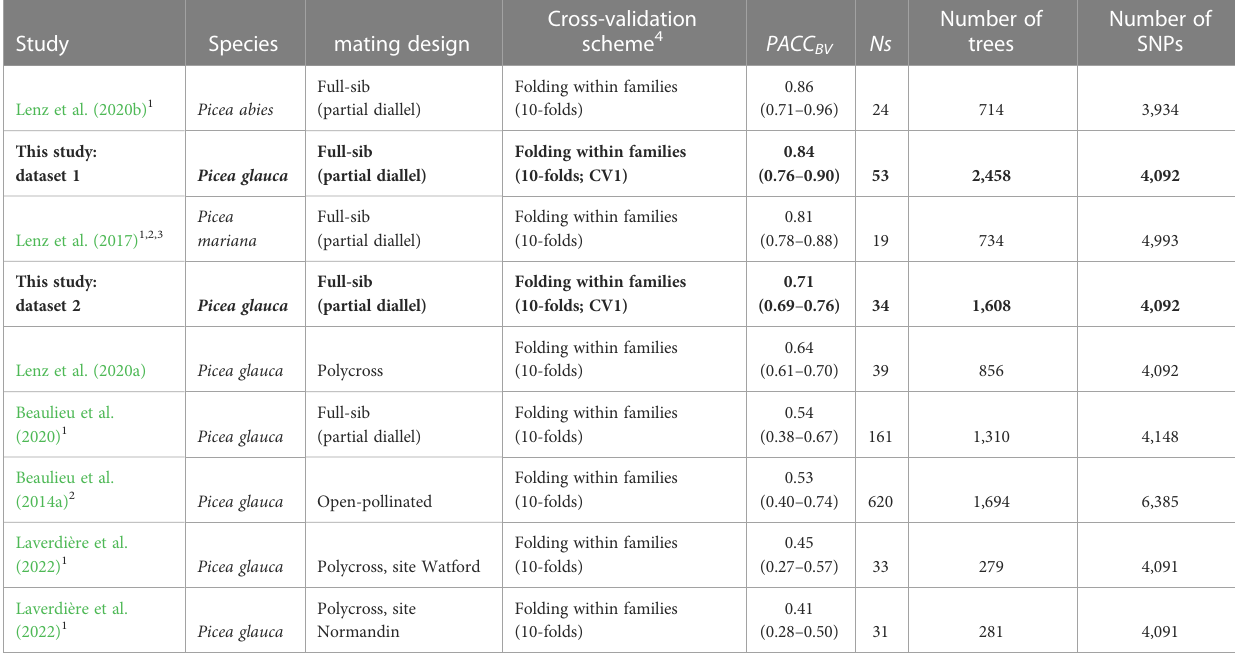
TABLE 5 Summary of previous spruce studies that estimated the predictive ability of breeding values ( PA BV : the correlation between the predicted breeding values and the phenotypes) using GBLUP-A